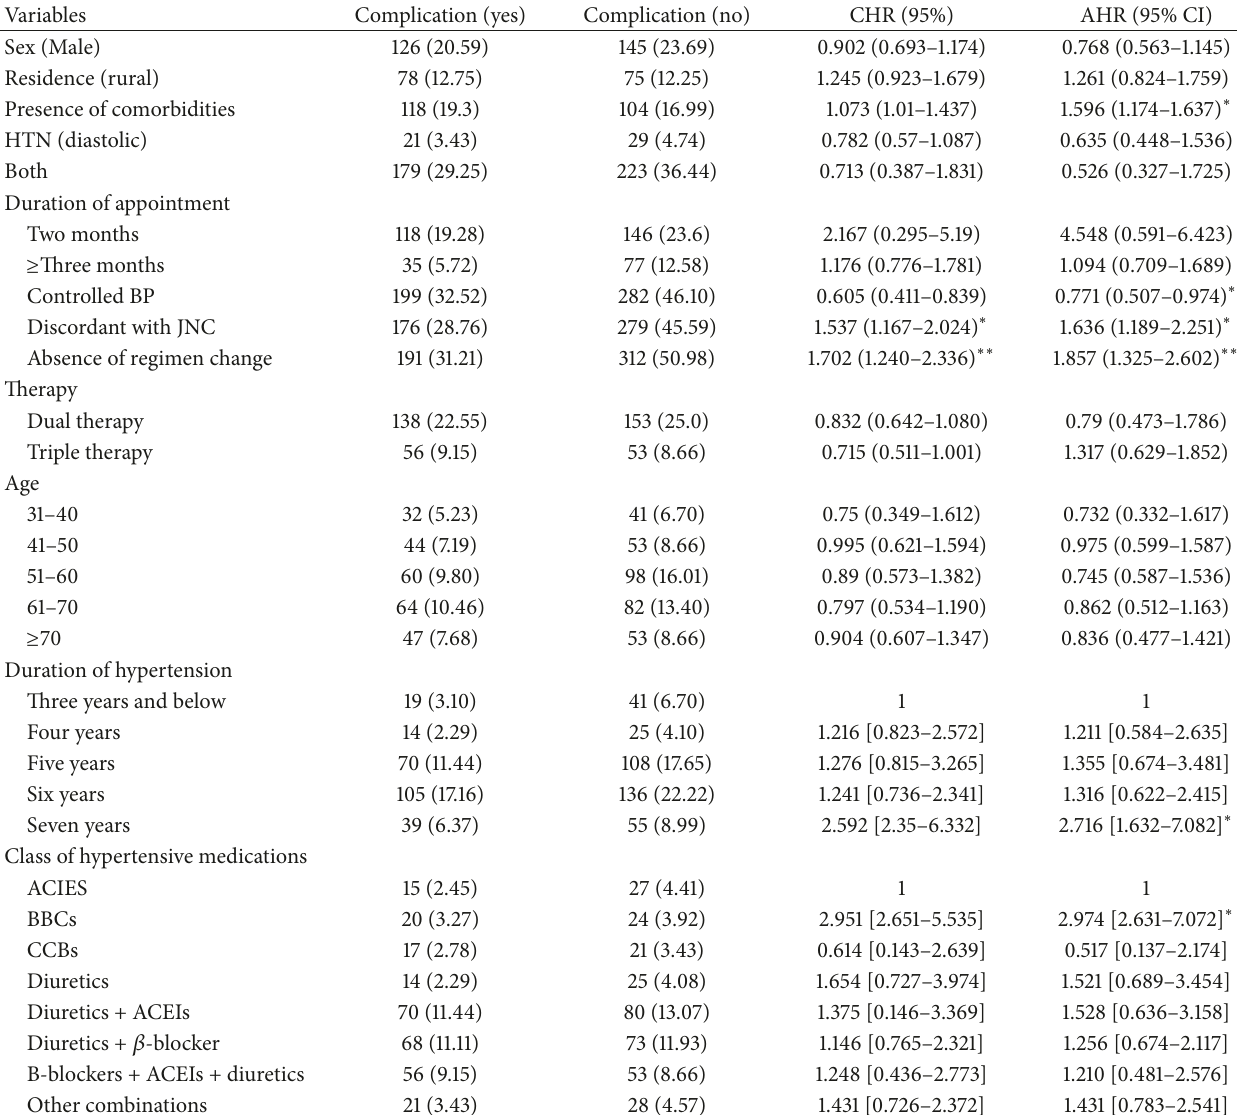
Table 4: Predictors of the target organ damage due to hypertension: multivariate cox